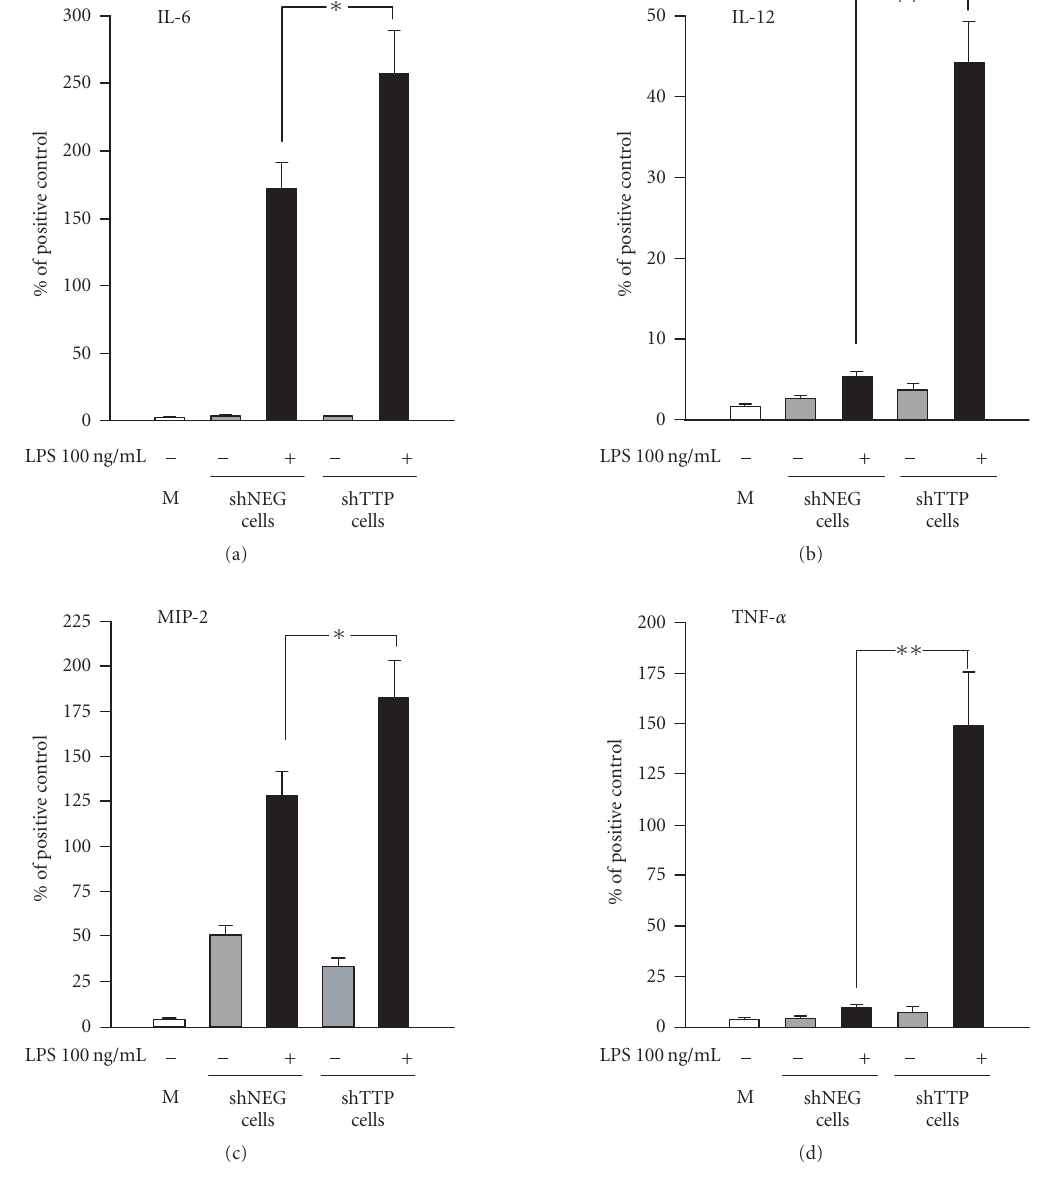
Figure 3: TTP down-regulation (shTTP cell line) enhanced the production of IL-6, IL-12, MIP-2, and TNF- α in response to LPS. Cytokine antibody array membranes were incubated in medium control (M) or in media from cultures of TTP knock-down cells (shTTP cell line) or control cells (shNEG cell line) after treatment with or without LPS (100ng/mL). Values are arbitrary units compared to positive controls SEM ( n = 3). (cid:2)(cid:2) = P < . 01, (cid:2) = P < . 05. (100) and are presented as mean (cid:0)